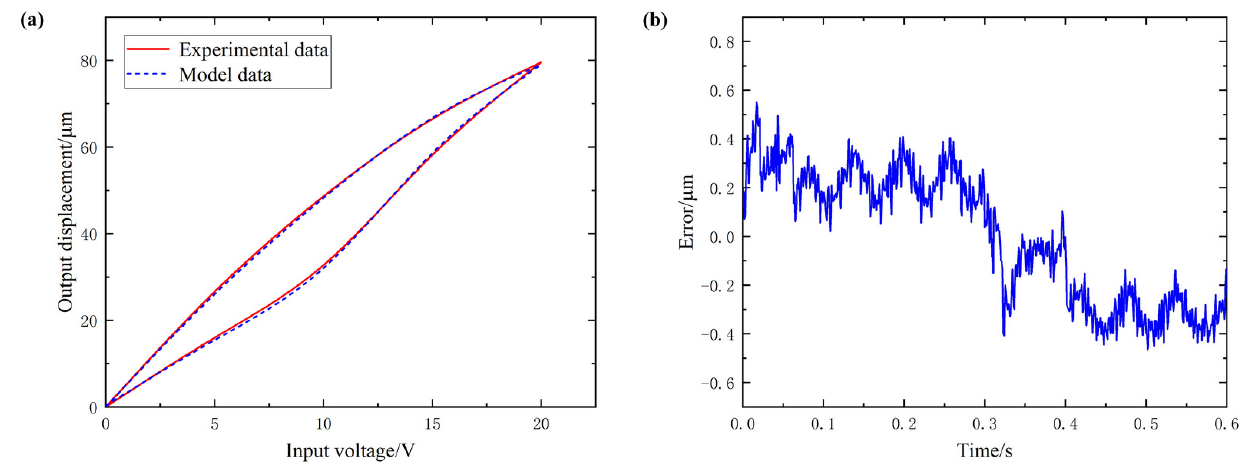
Figure 5. ( a ) hysteresis curve fitting of Y1 ( b ) fitting error of Y1.